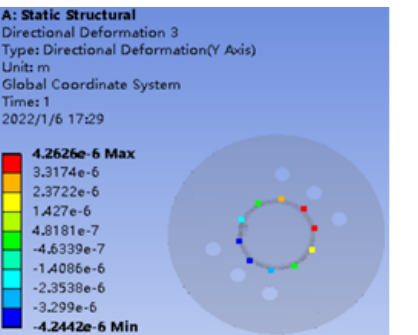
Figure 5. Cloud displacement in y direction of the transmission system.